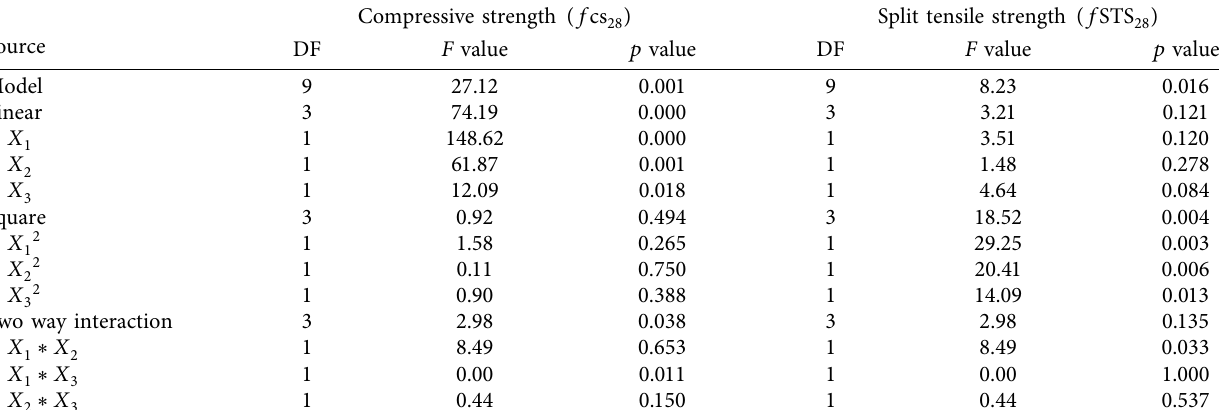
Table 4: Analysis of variance of RSM model.